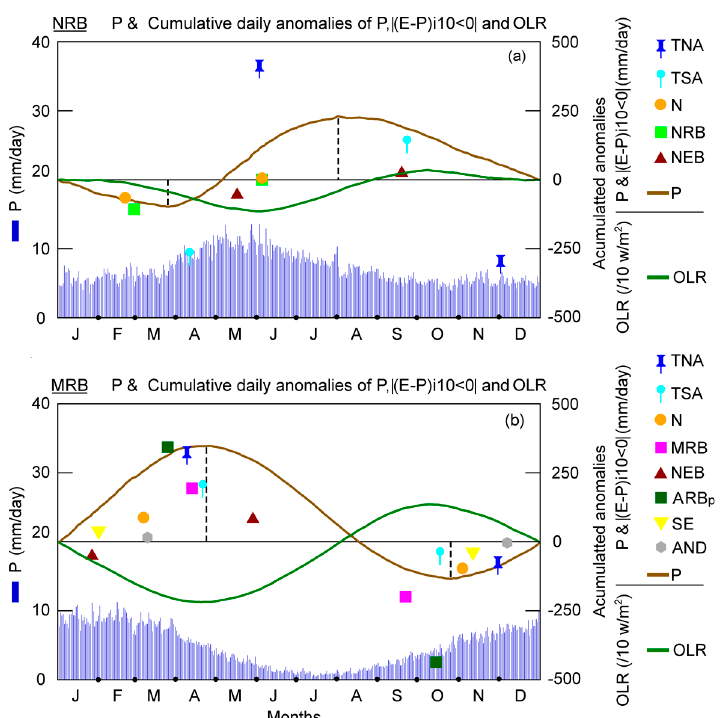
Figure 8. Daily P (blue bars) and cumulative daily anomalies of P from the CHIRPS datasets, OLR from NOAA and |( E − P ) i10 < 0 | over the NRB ( a ) and MRB ( b ) obtained in a forward experiment from the climatological moisture sources using FLEXPART. Period: 1981–2016.